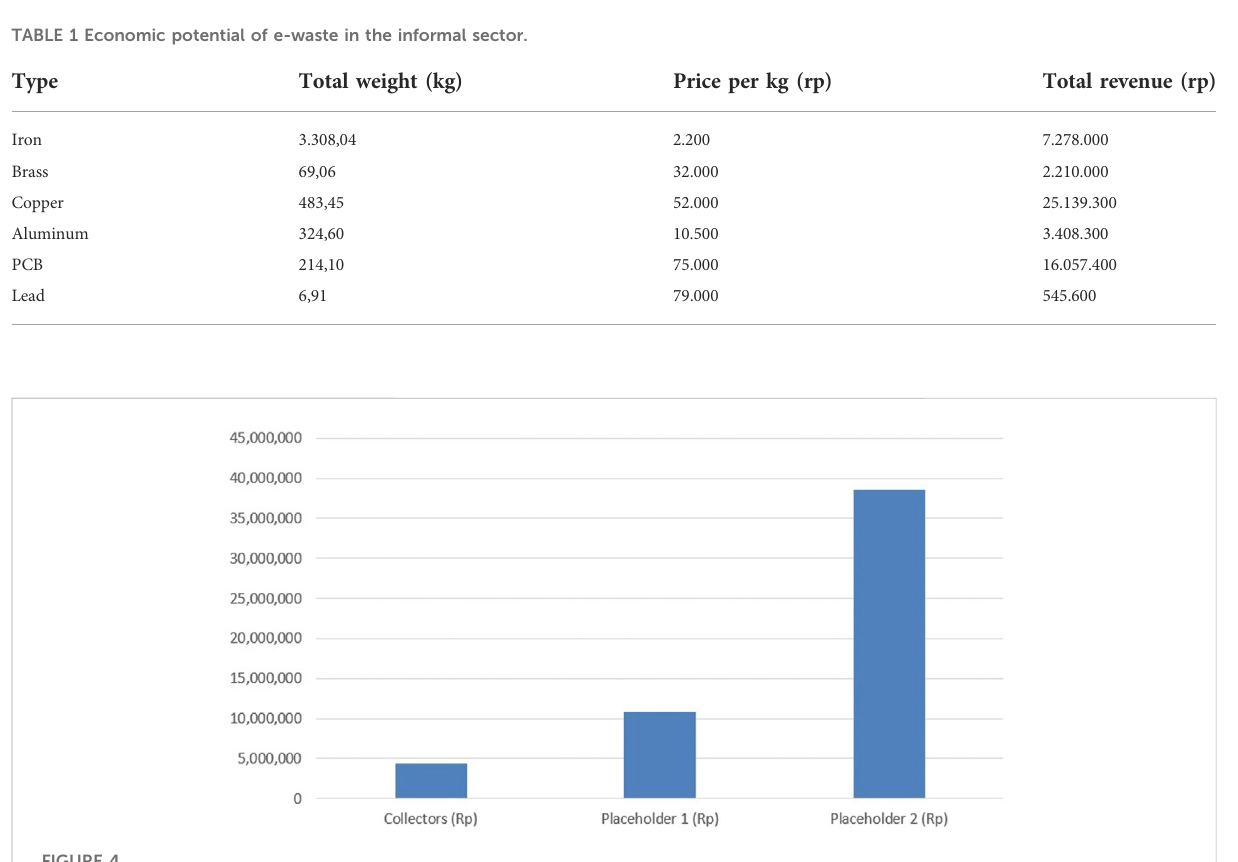
FIGURE 4 Differences in income in each of the informal e-waste recycling